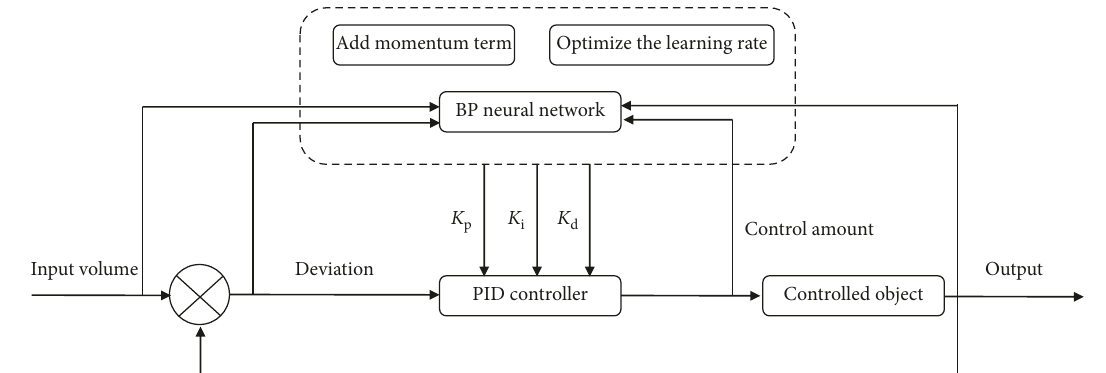
Figure 4: Improved BP neural network PID controller structure.